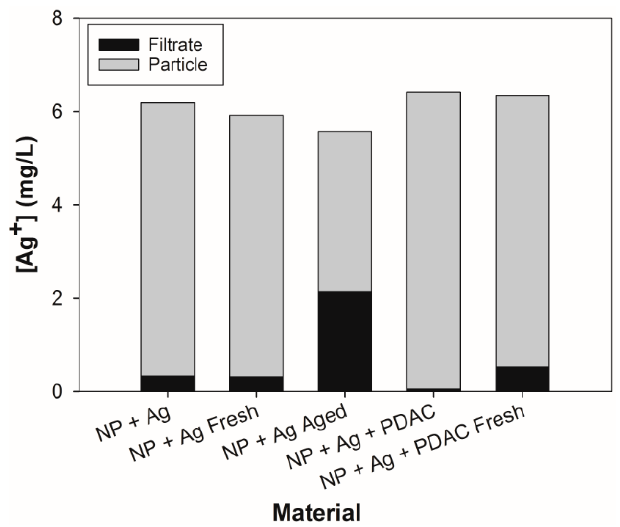
Figure 1. Concentration of silver associated with the filtrate and the particle as determined by ICP analysis. “Fresh” and “Aged” designations relate to the amount of time since the samples were dialyzed. All samples were analyzed via ICP-OES, except for the filtrate in the NP + Ag + PDAC sample, which was analyzed with ICP-MS.